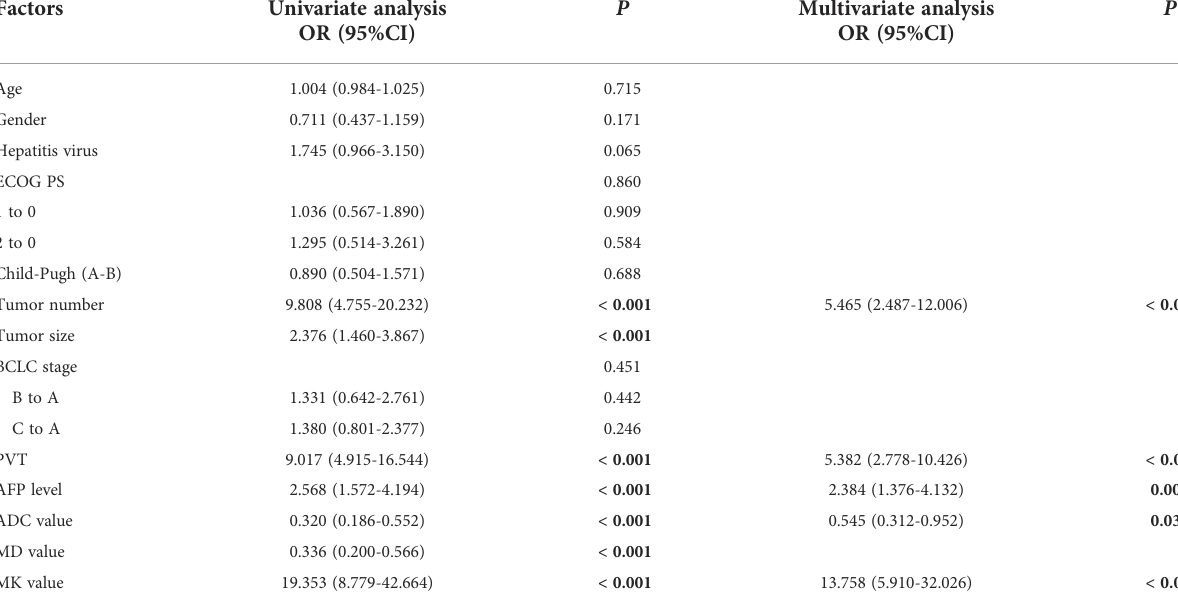
TABLE 3 Uni- and multi-variate analysis of predictors of recurrence free survival.